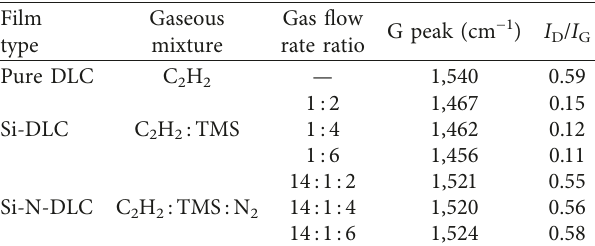
Table 2: G peak and ID/IG ratio of pure DLC, Si-DLC, and Si-N- DLC